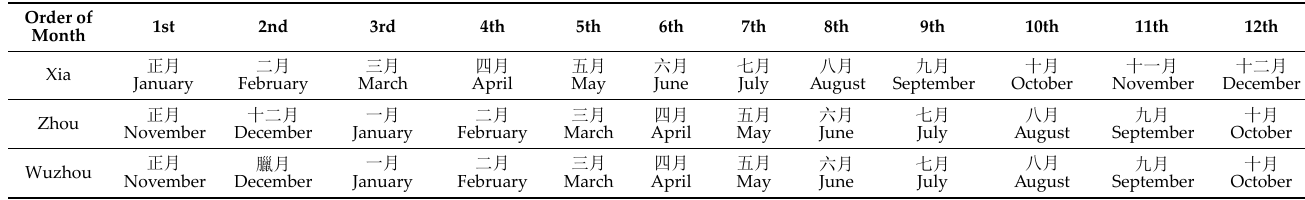
Table 5. The calendars of Zhou, Xia and